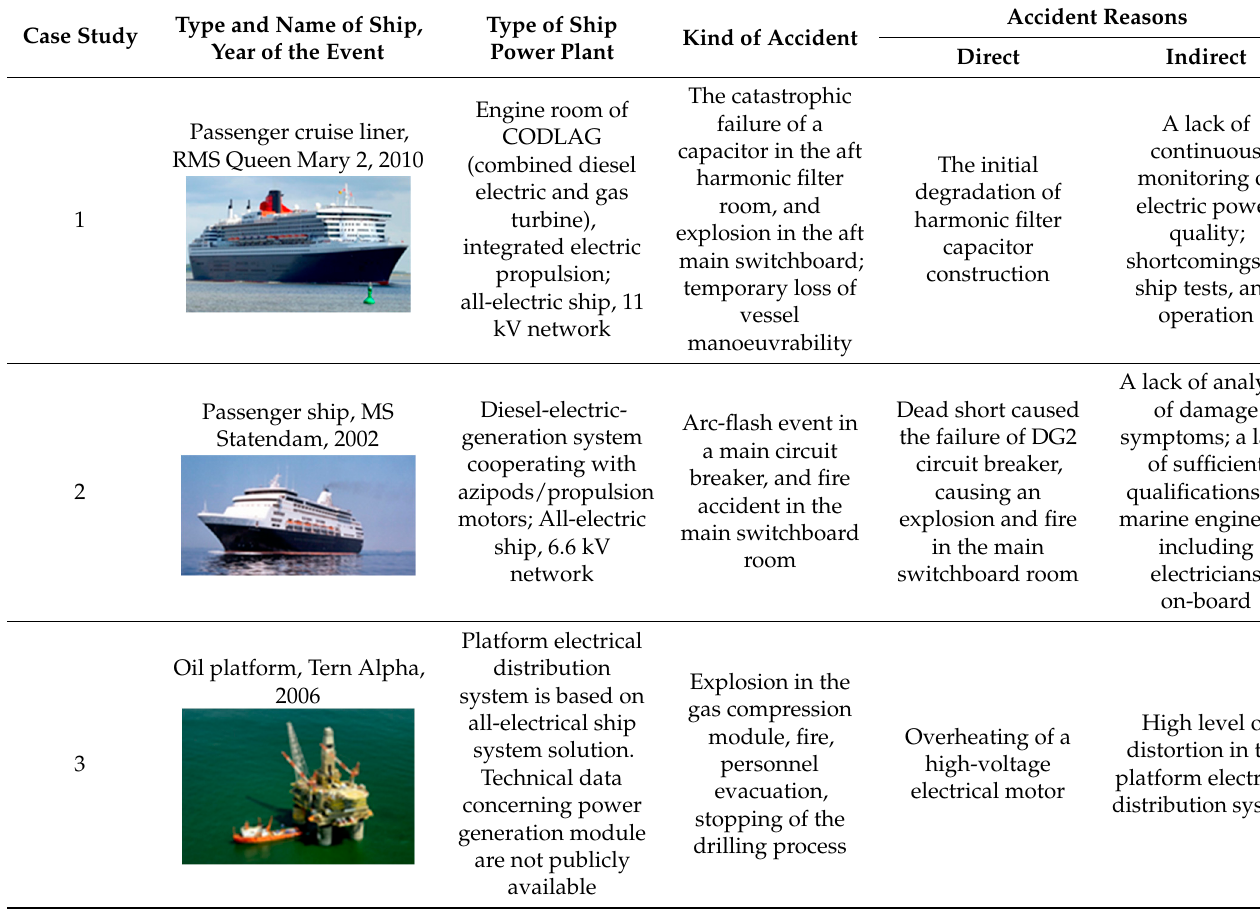
Table 1. Analysis of select power quality accidents [17,22–24].